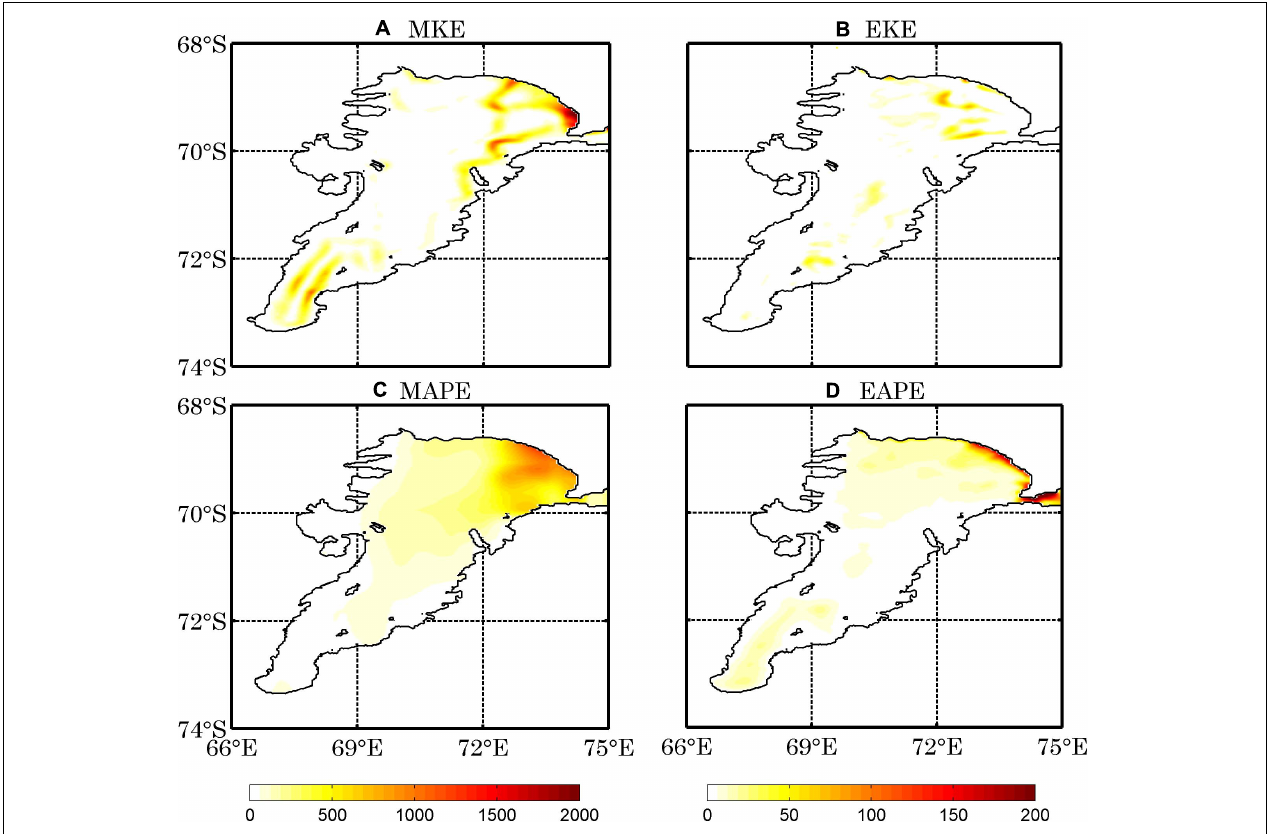
FIGURE 10 | The annual mean distributions of the vertically integrated MKE (A) , EKE (B) , MAPE (C) , and EAPE (D) in the Exp-shutdown experiment (J m − 2